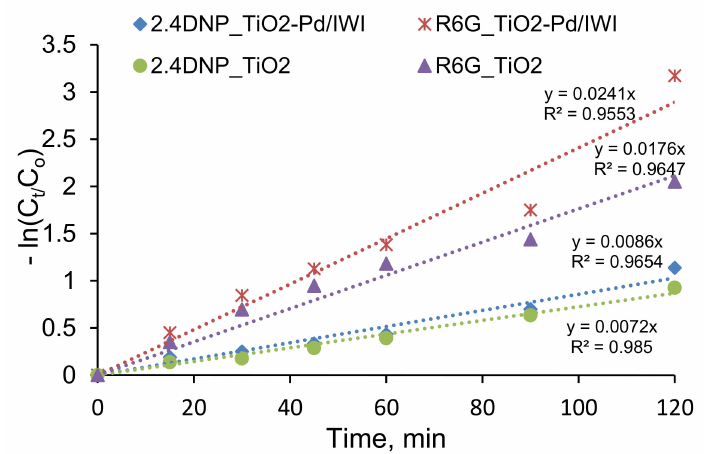
Figure 11. Reaction kinetics profiles for the degradation of 2,4 DNP and R6G in the presence of TiO 2 -Pd/IWI and TiO 2 . Experimental conditions: photocatalyst dose = 1g/L; pollutant = 20